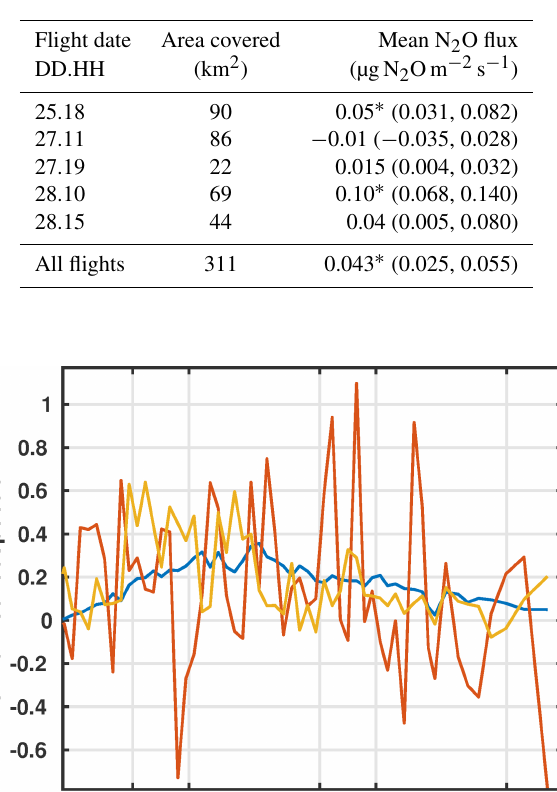
Table 2. Observed flux averages. The area covered is the footprint scope of the measurements made for each flight. Spatially averaged fluxes are presented with the bootstrap-derived 90% confidence in- tervals in parentheses. Asterisks indicate that the mean flux is sig-